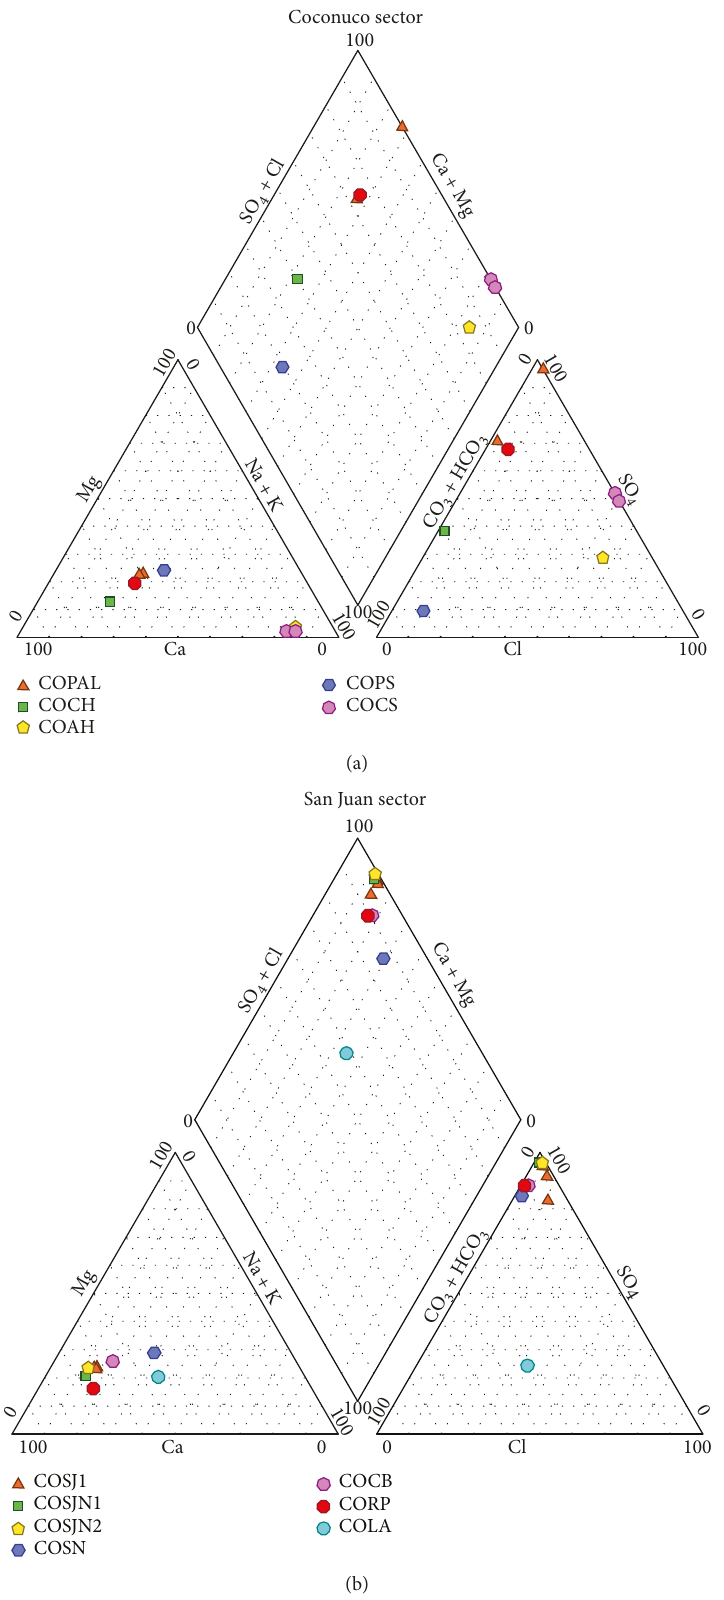
Figure 3: Piper diagram showing the hydro chemical compositions: (a) Coconuco sector and (b) San Juan